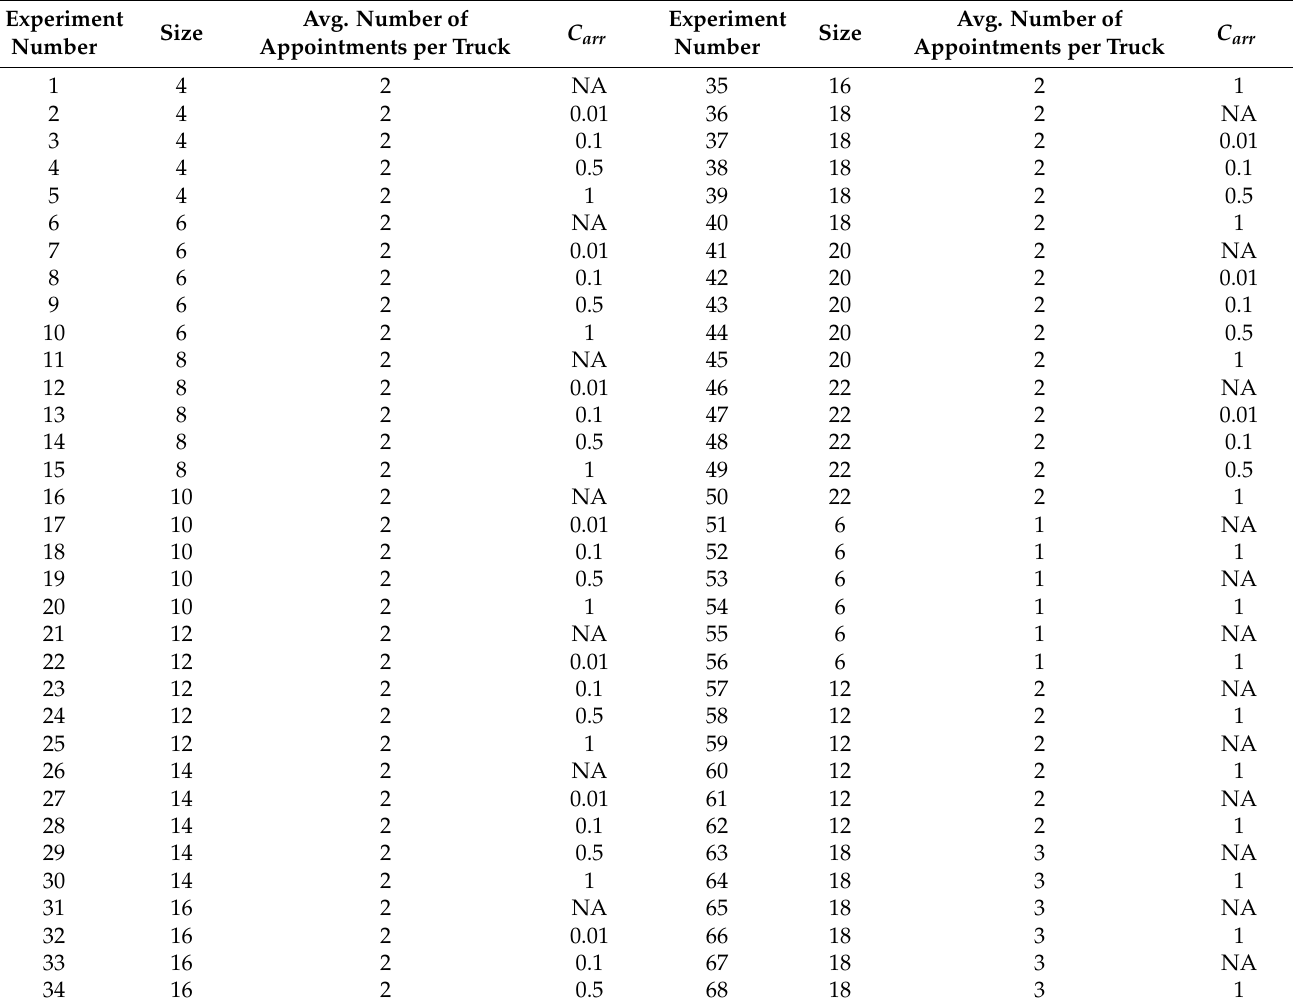
Table 5. Parameters of the TAS